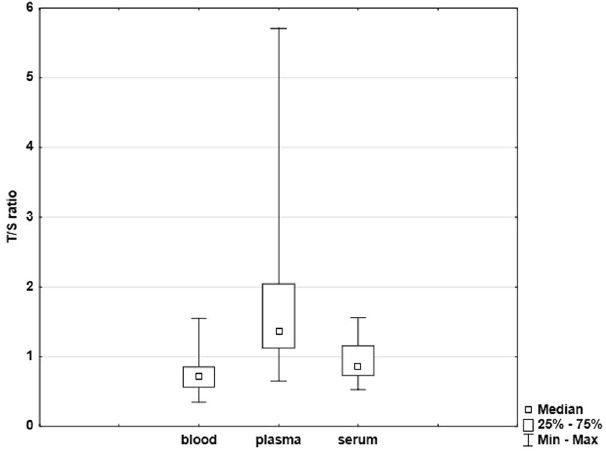
Figure 2. Box plot showing relative T/S ratios for whole blood, plasma and serum samples (n = 36).